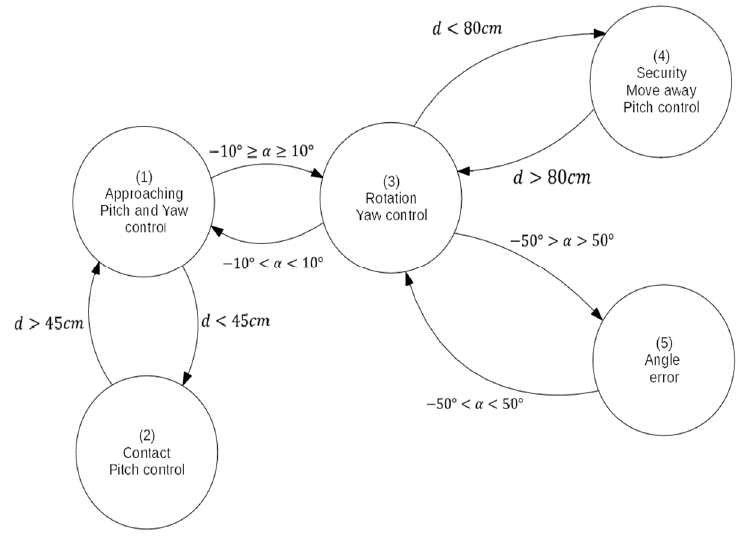
Figure 9. Hybrid automaton of the contact mode.